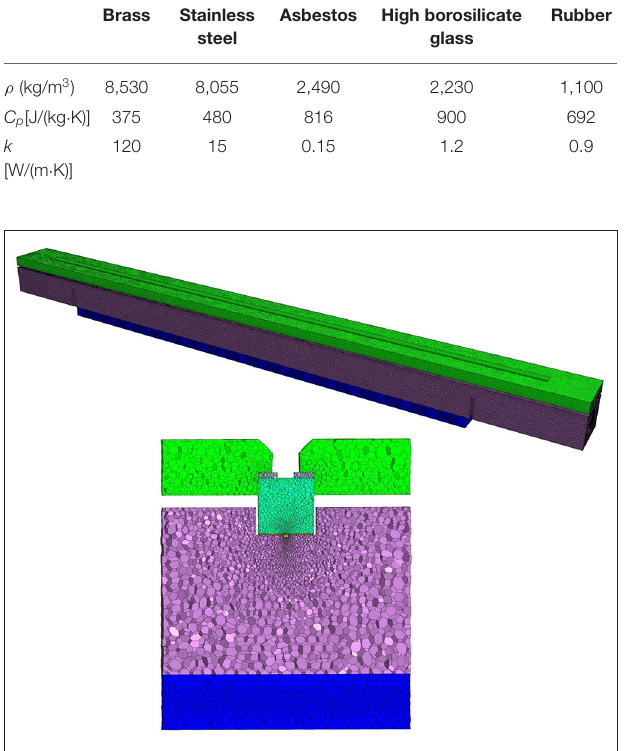
the formula are regarded as the area average value,